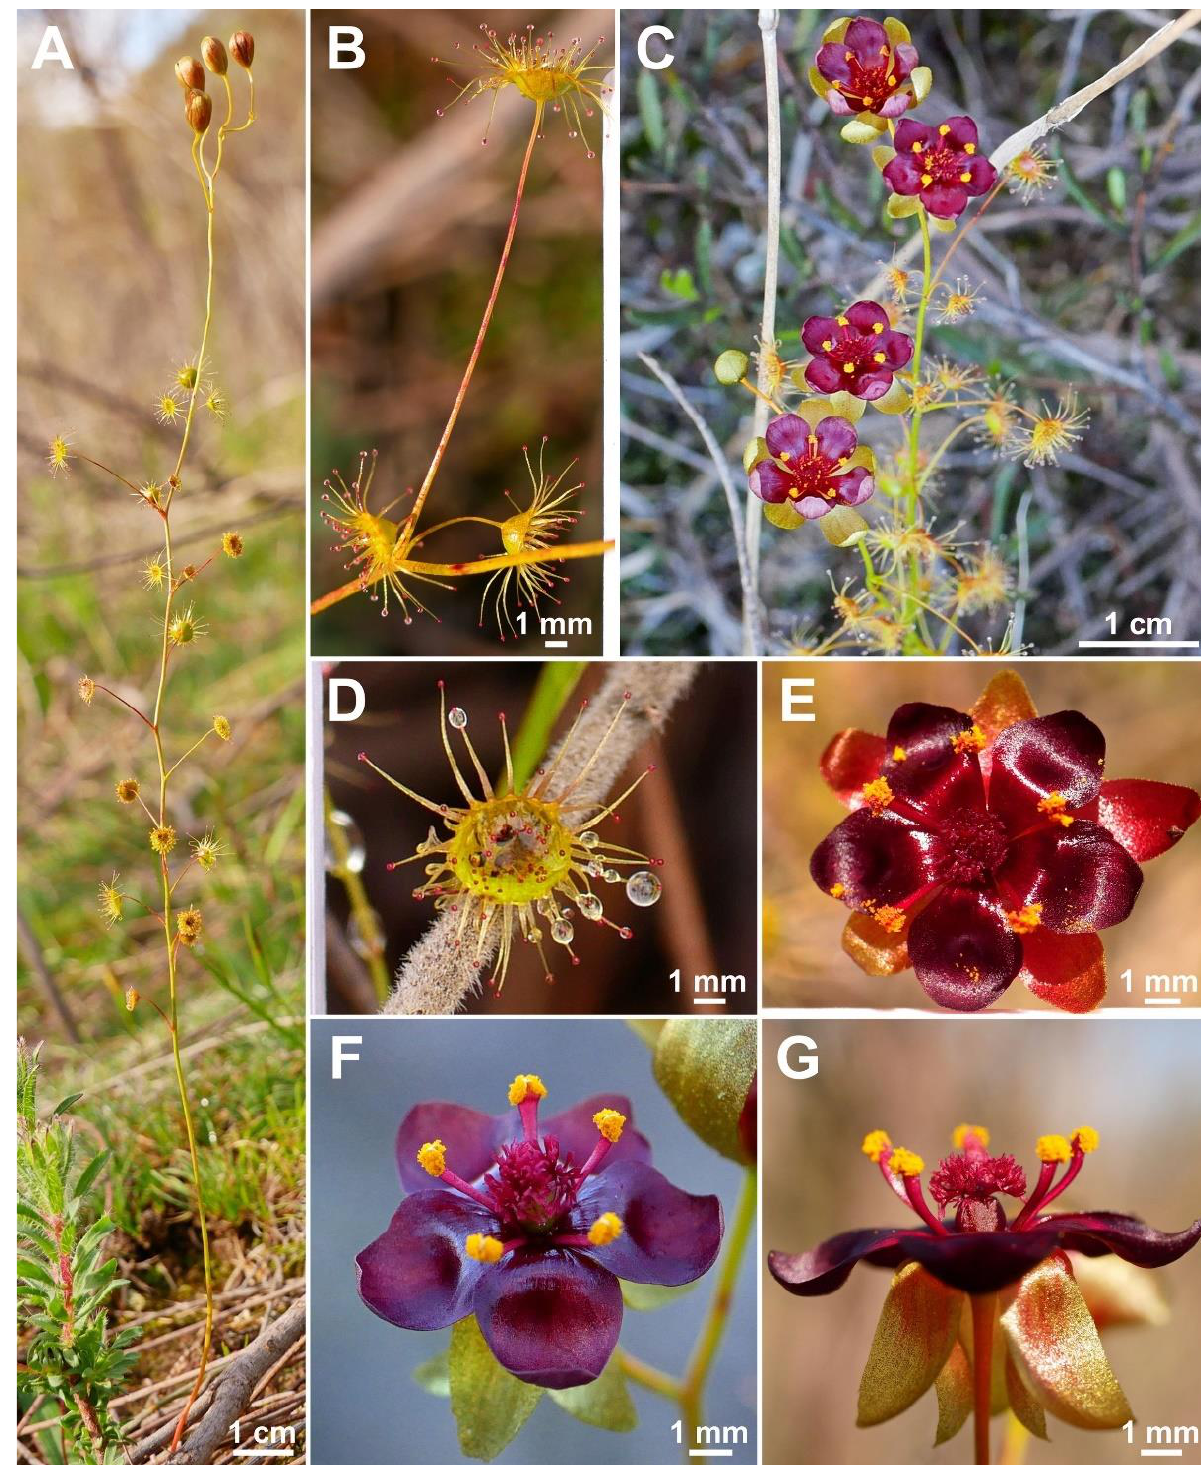
Figure 9. Drosera hortiorum T.Krueger & G.Bourke. ( A ) habit; ( B ) leaf on the upper part of the stem exhibiting two smaller axillary leaves emerging from the leaf axil; ( C ) group of flowering plants; ( D ) lamina, this species has an orbiculate lamina shape (sometimes with a sightly flattened upper margin); ( E ) flower in bright sunlight; ( F ) flower in diffuse light; and ( G ) flower, lateral view. ( A , B , E ) from Wandoo National Park, Western Australia, 20 August 2022. ( C , F , G ) from near Wickepin, Western Australia, 1 July 2022. ( D ) from near York, Western Australia, 4 September 2022. Images: T. Krueger.